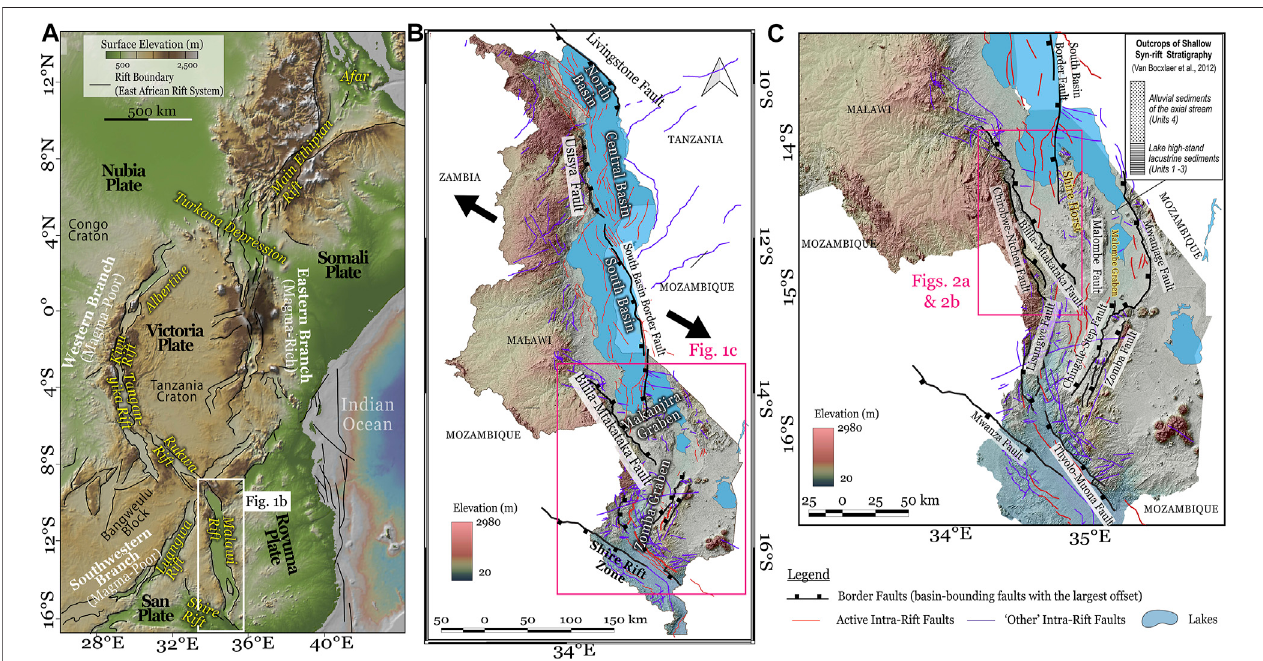
FIGURE 1 | (A) Simpli fi ed tectonic map of the East African Rift systems (EARS). Topographic relief basemap is obtained from GeoMapApp (Ryan et al., 2009), (B) Digital elevation model (DEM) hillshade map of the study area highlighting the surface topography, faults, and sub-basins along the Malawi Rift, (C) DEM hillshade map covering the southern Malawi showing structures in both the Southern Malawi Rift and the Shire Rift Zone further south. The fault traces are obtained from Malawi Rift ’ s fault database in Williams et al. (2021). The inset shows the shallow syn-rift sediments revealed in outcrops of the Chipalamawamba Beds along the Malombe Graben (Van Bocxlaer et al.,